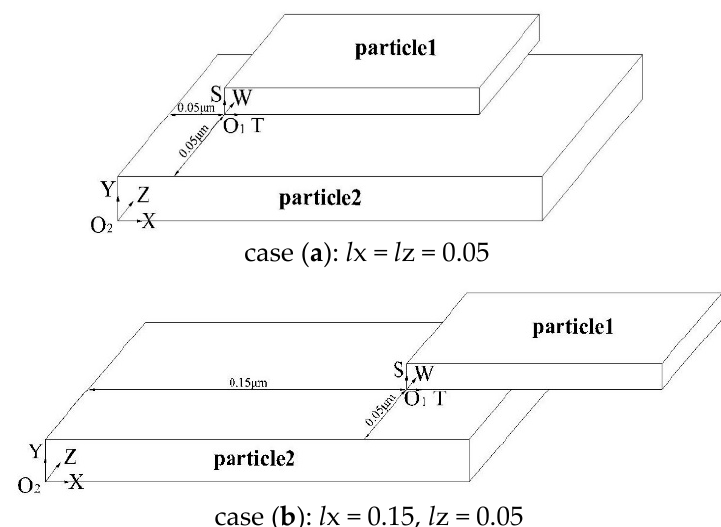
Figure 6. Two specific cases of face-face contact